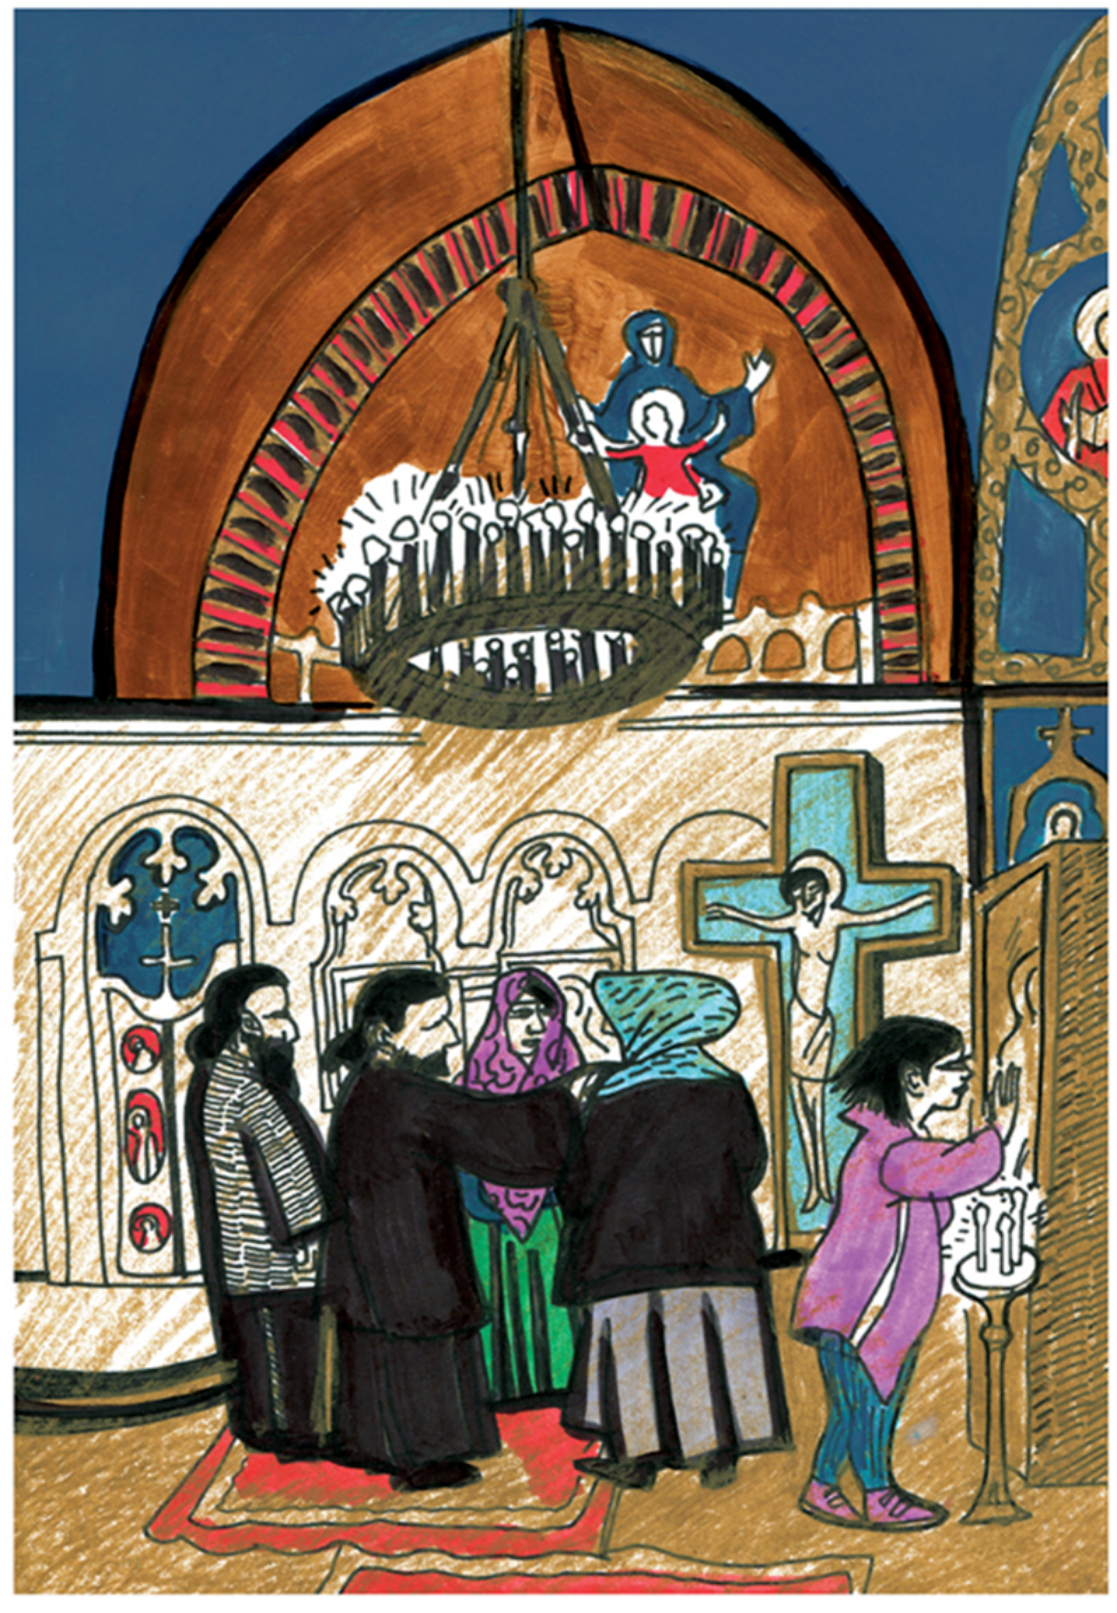
Figure 2 Victoria Lomasko, A Trip to Minsk, the part of the book The Last Soviet